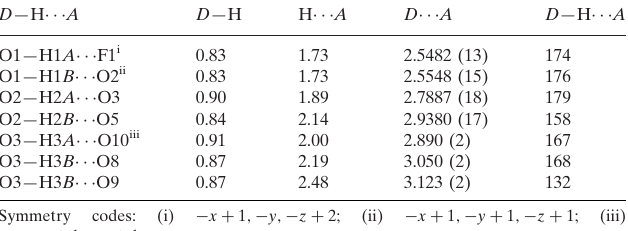
Hydrogen-bond geometry (A˚ , (cid:4) ).